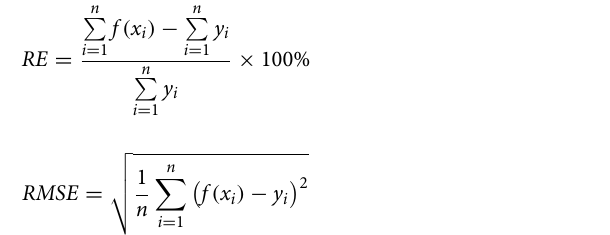
starch content corresponding to x i ; and n = 5 represents the five sampling times within the dehardening period. The validation result of the models was shown in Table 2. The quadratic regression model for soluble sugar content prediction ( y = 0.142 x 2 − 0.823 x + 6.757) had the greatest R 2 (0.897), and the smallest RMSE (0.811),